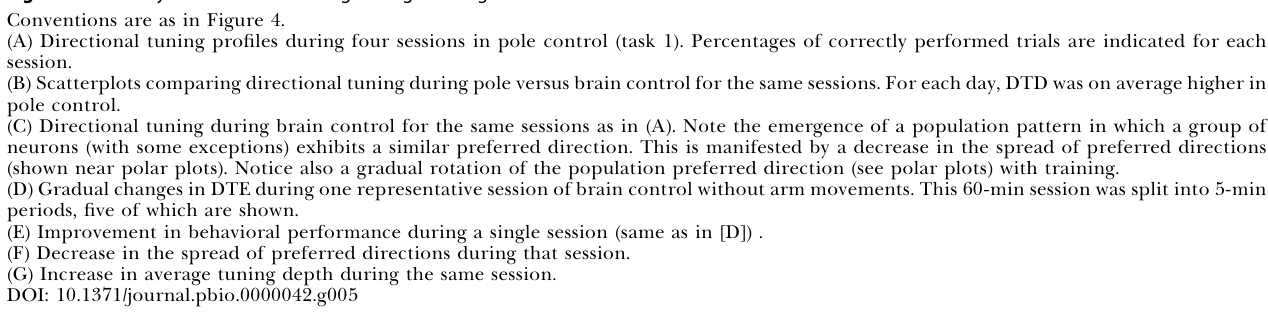
Figure 5. Plasticity of Directional Tuning during Training in Brain Control without Arm Movements Conventions are as in Figure 4. (A) Directional tuning profiles during four sessions in pole control (task 1). Percentages of correctly performed trials are indicated for each session. (B) Scatterplots comparing directional tuning during pole versus brain control for the same sessions. For each day, DTD was on average higher in pole control. (C) Directional tuning during brain control for the same sessions as in (A). Note the emergence of a population pattern in which a group of neurons (with some exceptions) exhibits a similar preferred direction. This is manifested by a decrease in the spread of preferred directions (shown near polar plots). Notice also a gradual rotation of the population preferred direction (see polar plots) with training. (D) Gradual changes in DTE during one representative session of brain control without arm movements. This 60-min session was split into 5-min periods, five of which are shown. (E) Improvement in behavioral performance during a single session (same as in [D]) . (F) Decrease in the spread of preferred directions during that session. (G) Increase in average tuning depth during the same session. DOI: